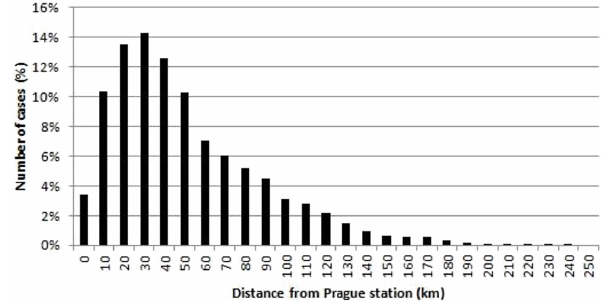
Fig. 10. Distribution of horizontal distance of radiosonde from the Prague station in 10hPa (irrespective of wind direction) for the win- ters of 2005 to